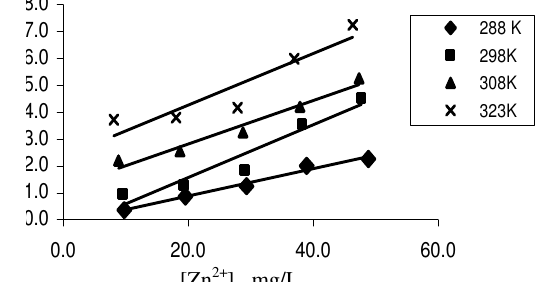
versus [Zn 2+ ] ads